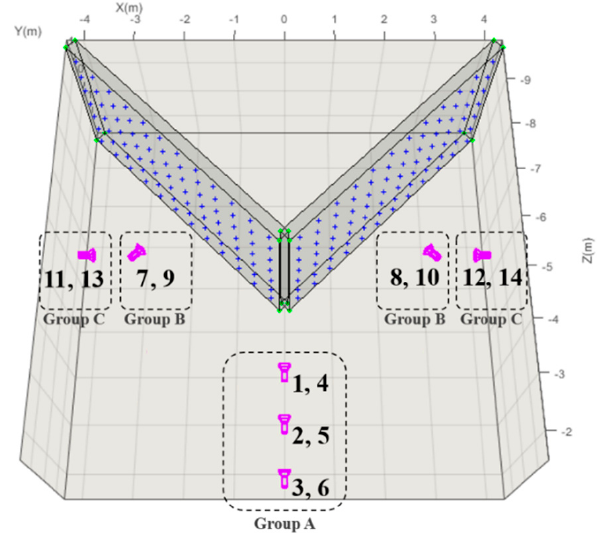
Figure 8. Configuration of image acquisition for additional experiments. Table 15. Explanation of image groups shown in Figure 8.